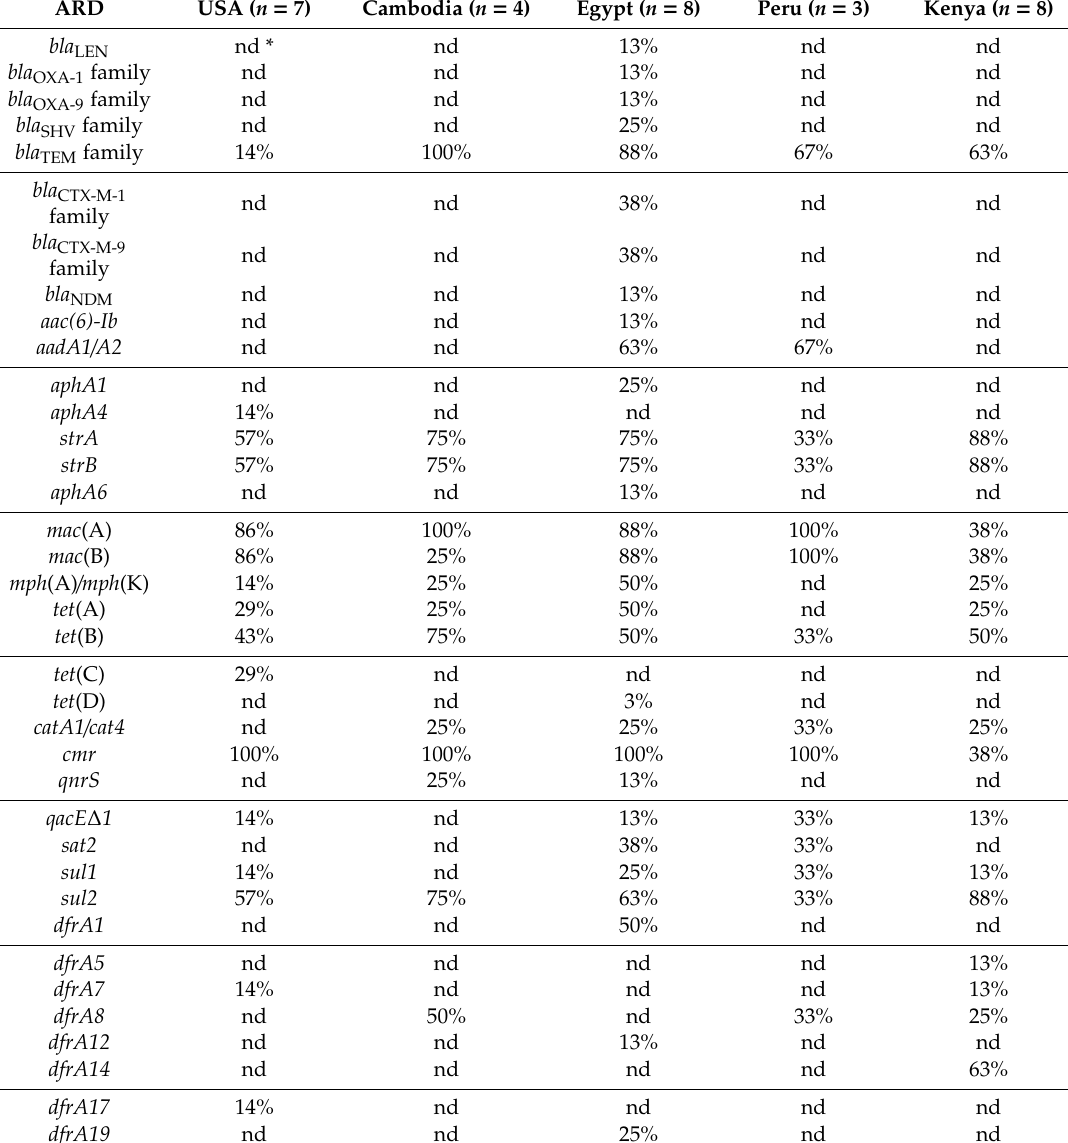
Table 3. ARDs detected in E. coli , by geographic location (percent of isolates